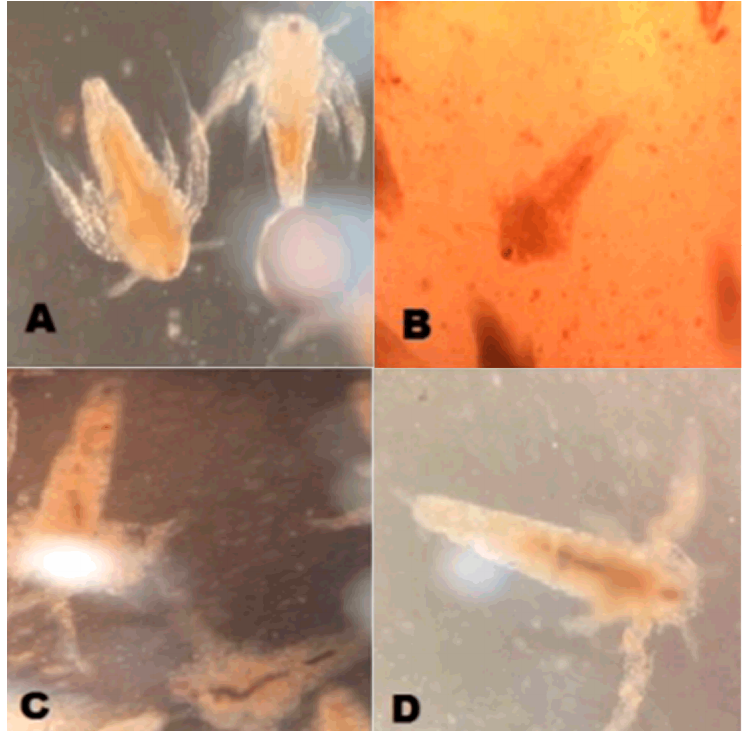
Figure 2. Digestive tract of Artemia after the marking step. ( A )—No marker control; ( B )—Titanium Dioxide; ( C )—Chromic Oxide; ( D )—NANOLIPE ® . Table 2. Concentration of the markers Chromium Oxide (T2), Titanium Dioxide (T3) and NANOLIPE ® (T4) (mean ± standard deviation) found in Artemia at the exposure periods of 30, 60 and 90